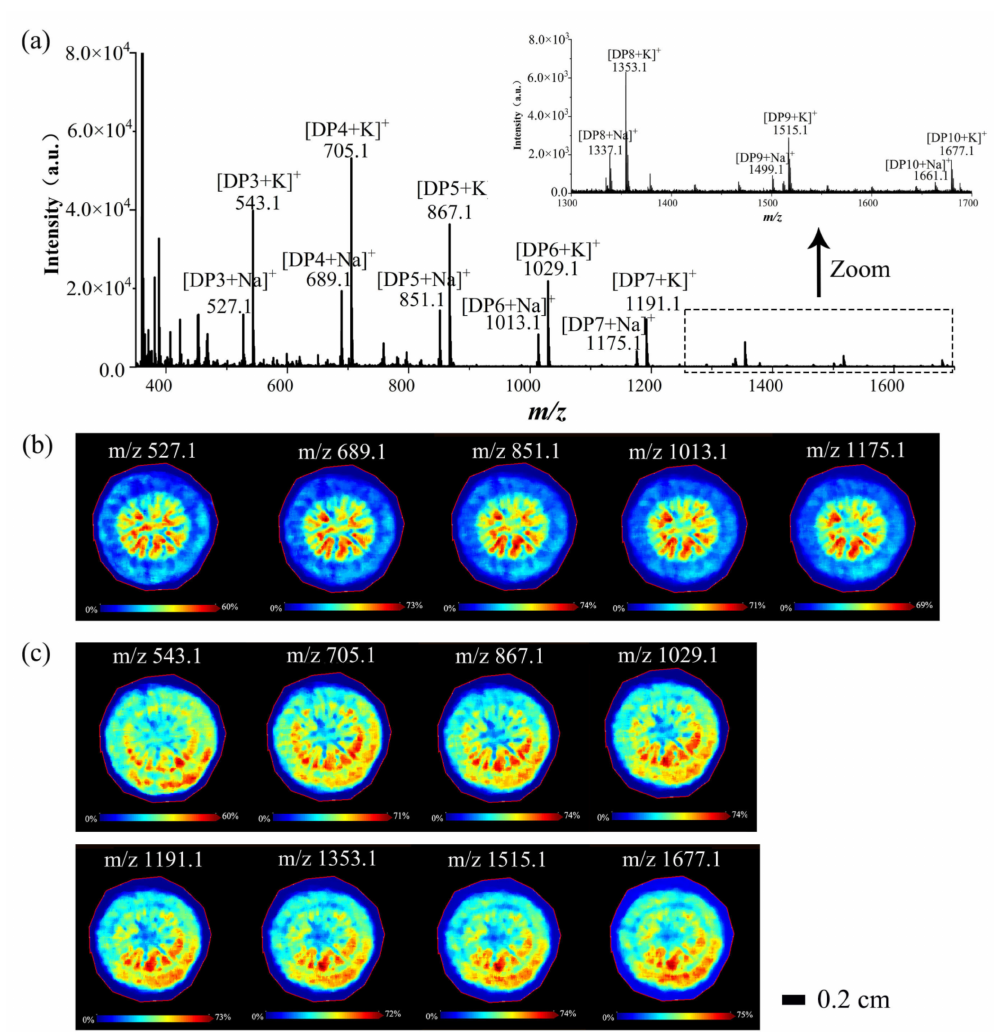
Figure 3. MALDI MS and imaging of saccharides of A. lappa roots. MALDI MS ( a ) and images of saccharides in A. lappa roots, including [M + Na] + ( b ); [M + K] + ( c ). Data were collected from the Yanagawa-riso variety in positive ion reflector